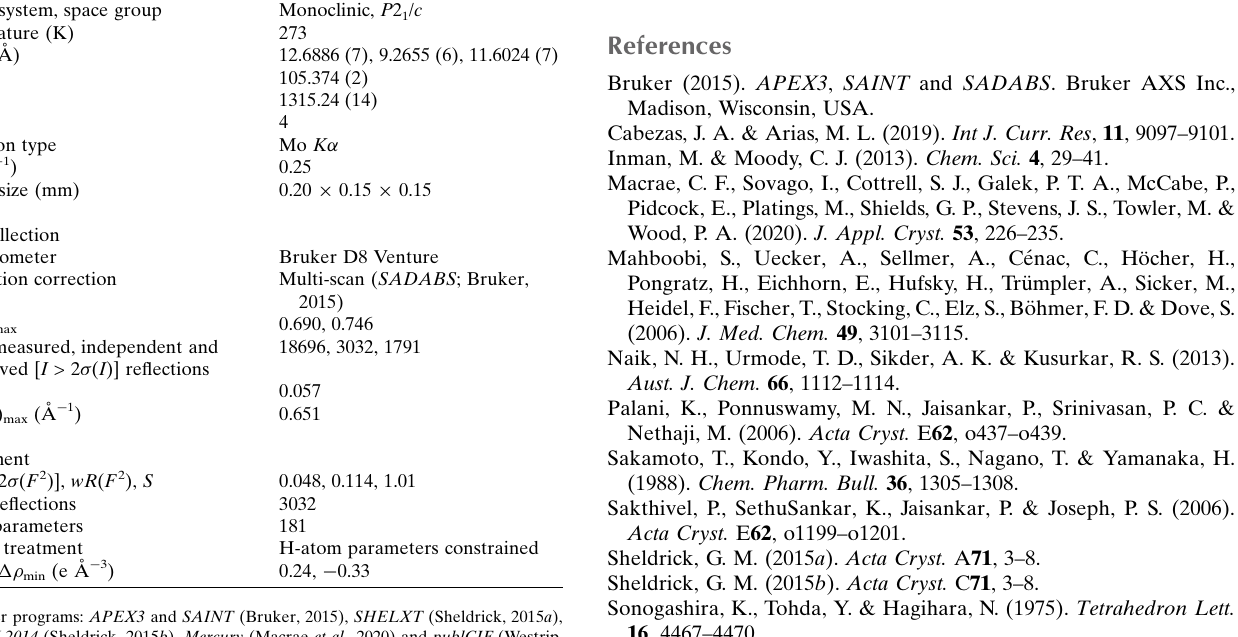
Table 2 Experimental details. Crystal data Chemical